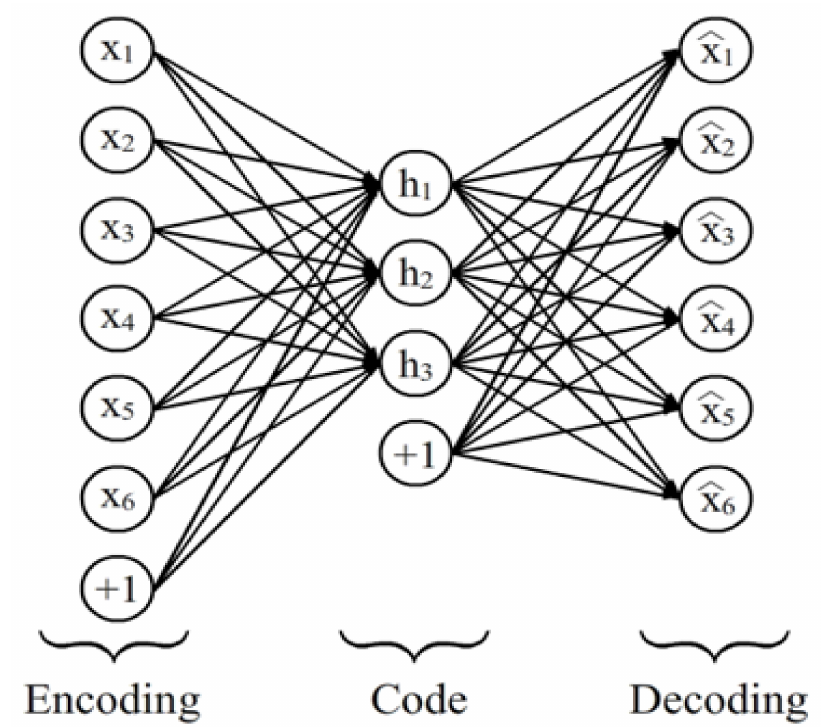
Figure 4. Schematic diagram and layers of the